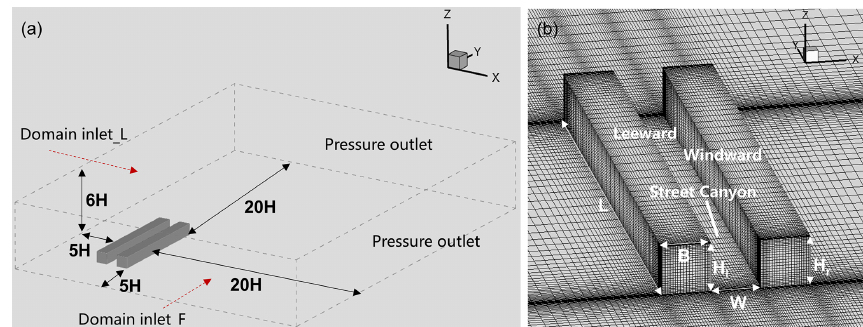
Figure 2. Computational domain (a) and grid arrangement (b) in all CFD test